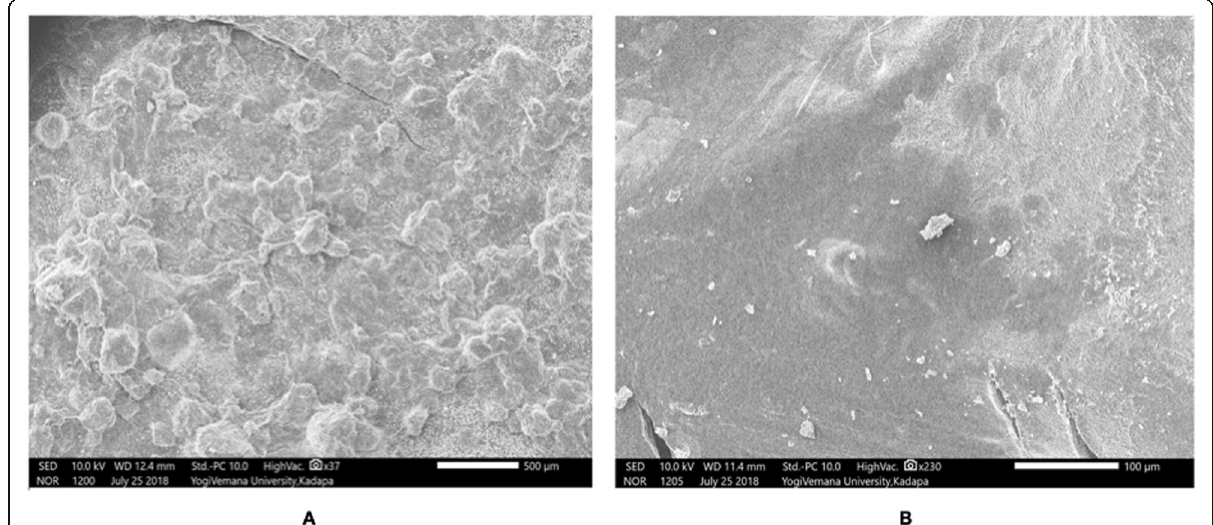
Fig. 2 SEM images of prepared bioscaffold. a Chitosan-hydroxyapatite bioscaffold. b Chitosan-hydroxyapatite calcium chloride cross-linked